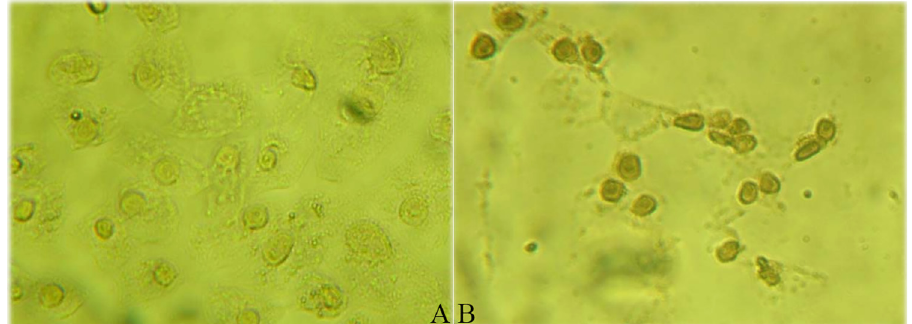
Fig 3. Transferring HPhA from the fusion protein rPE-HPhA into cytosol with immunohistochemical method. The fixated cells were incubated with anti-HPhA mAb followed by interaction with goat anti-mouse IgG horseradish peroxidase conjugated antibody as secondary antibody, and stained with diaminobenzidine (DAB). A) Untreated HeLa cells without immunohistochemical staining observed. B) Immunohistochemical staining was observed in HeLa cells treated with fusion protein